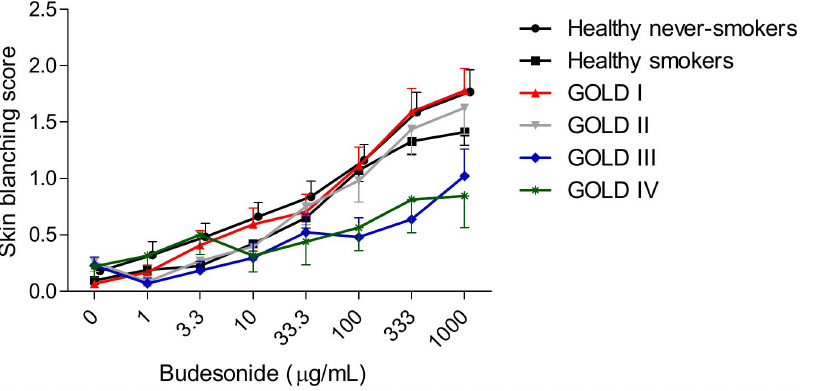
Figure 3. Dose-response curves of budesonide in healthy controls and COPD patients GOLD stages I–IV. Values are expressed as mean 6 SEM.